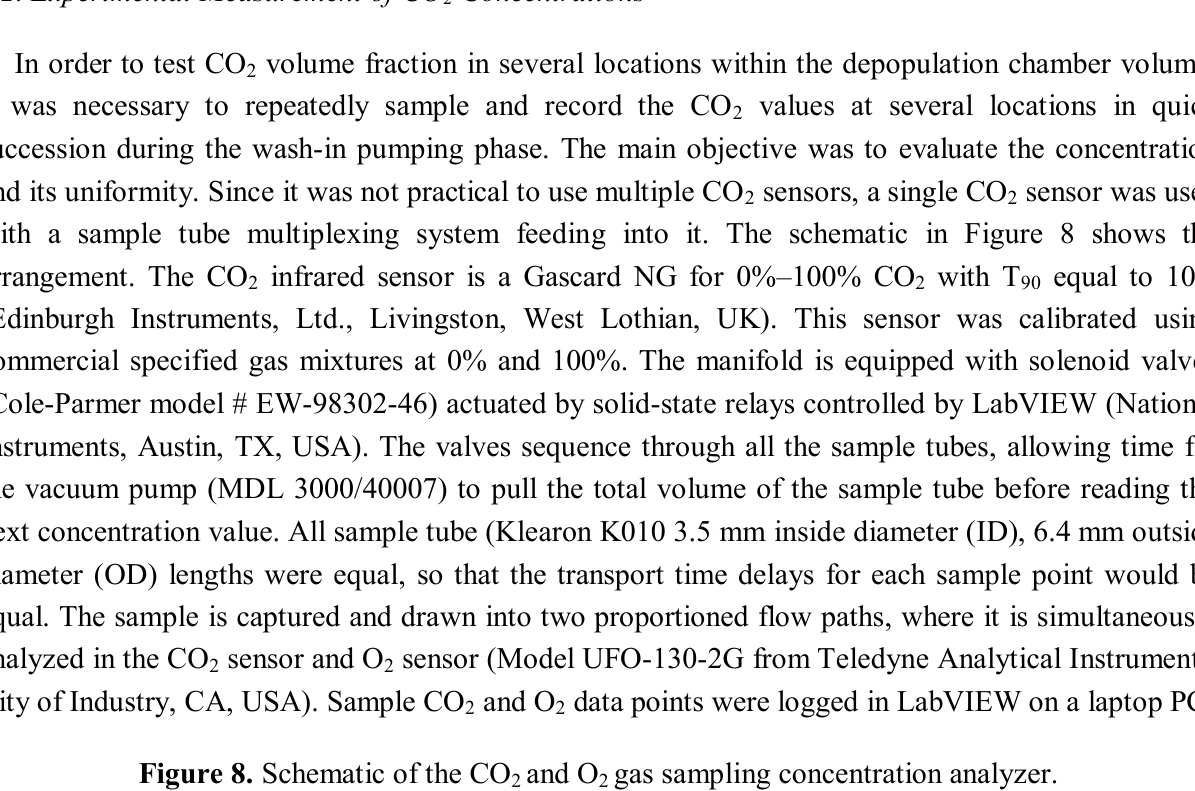
Figure 8. Schematic of the CO